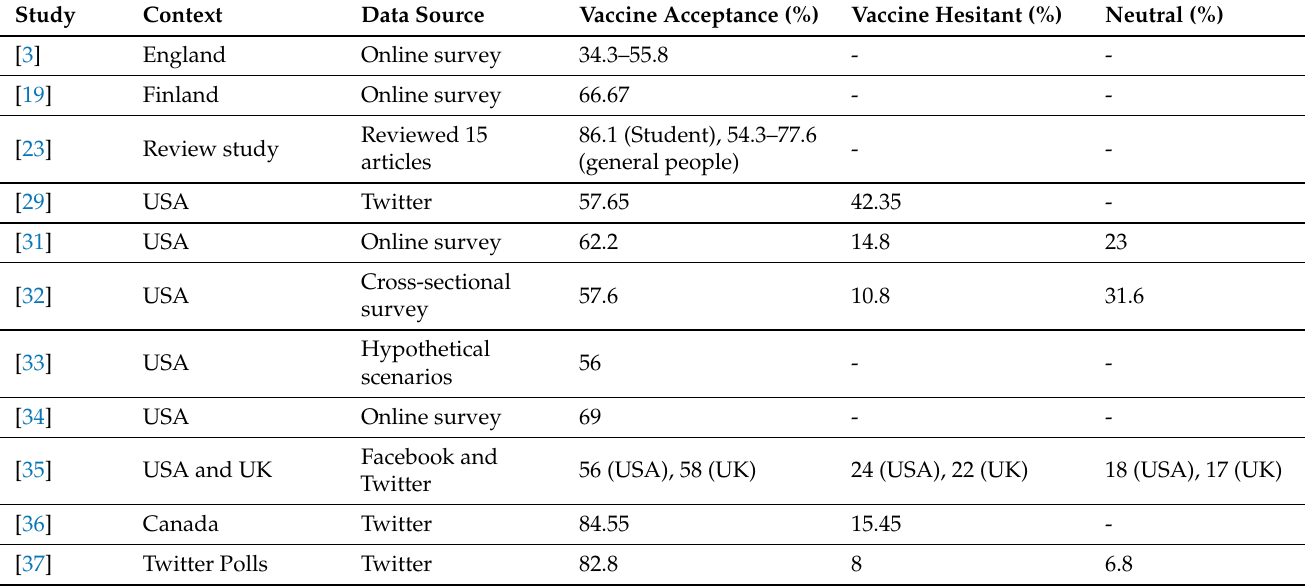
Table 1. Perceptions of the public towards COVID-19